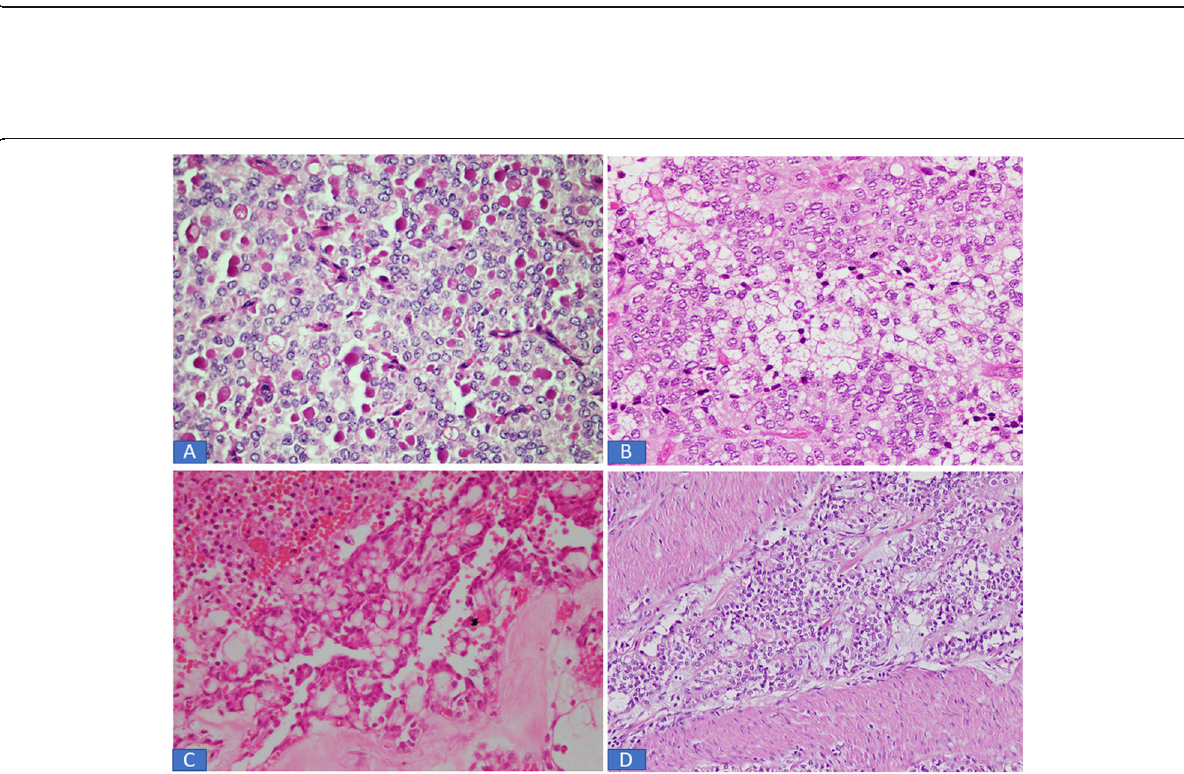
Fig. 2 a Pseudopapillary structures are a prominent feature in SPN. Tumor cells with eosinophilic cytoplasm are arranged around delicate fibrovascular cores b Fibrovascular cores often demonstrate a myxoid stroma. c Solid sheets of tumor cells. Some vascular cores can be seen. d Cells with clear cytoplasm